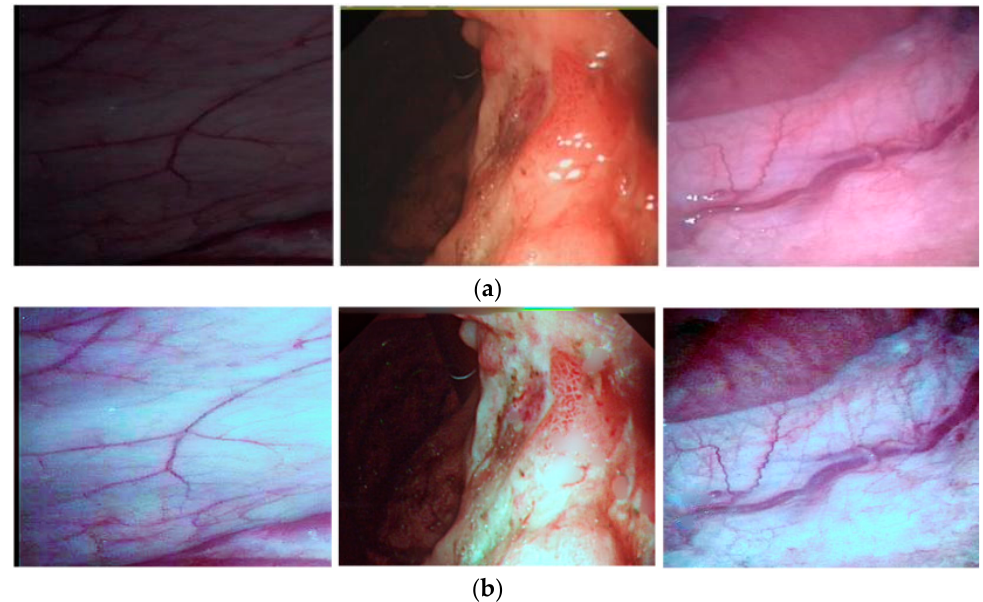
Figure 9. Endoscopic IE results: ( a ) original images and ( b ) enhanced images using our algorithm.